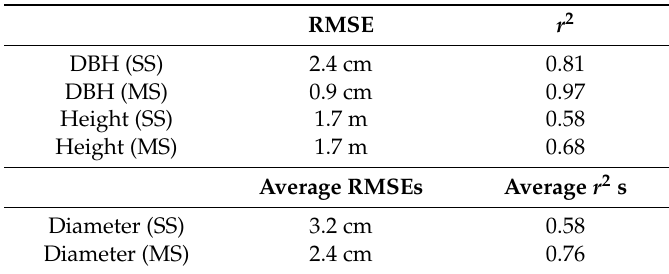
Figure 7. Automation outcomes for tree No.23 from plot-1 MS. ( a ) raw isolated point clouds, colored by point intensity; ( b ) segmentation of the point clouds within 1 m horizontal distance to the stem location, colored by the segment random identity numbers; ( c ) a vertical section cutting tree in half, with branches in blue and classified stem in white; ( d ) stem radius and stem curve, represented by colored stem node circles and red connection line of stem nodes, respectively. The results are shown in local Cartesian coordinate system with plot center as the origin. Table 2. Accuracy assessment for stem attributes.